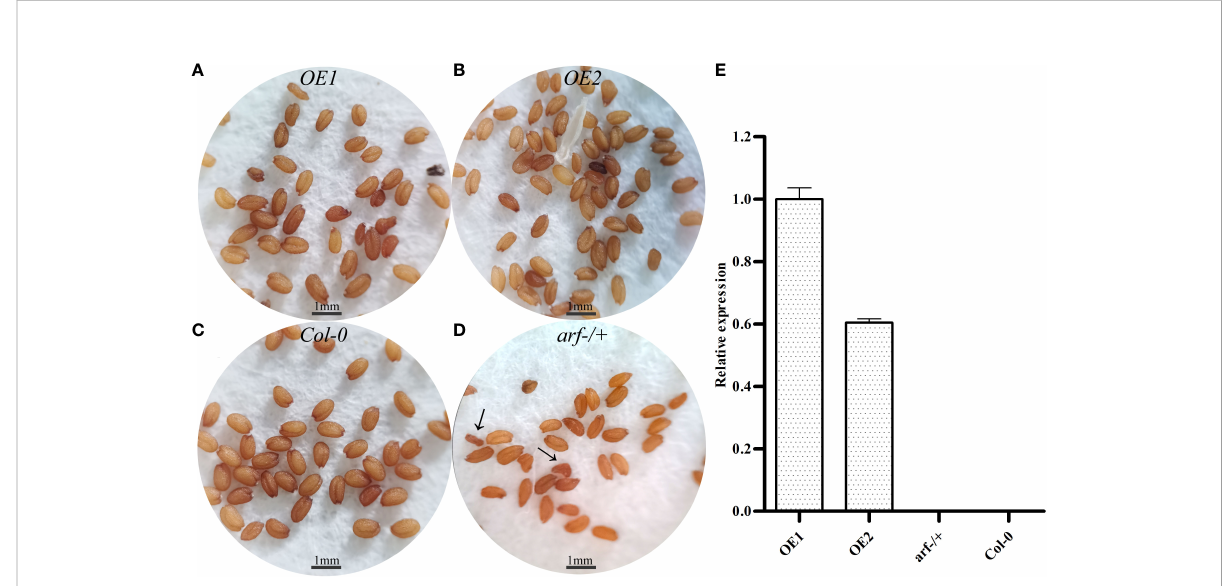
FIGURE 4 Phenotypes of transgenic A. thaliana overexpressing MsARF5 . (A-D) : Seed morphology of OE1, OE2, WT ( Col-0 ) and arf-/+ (heterozygous mutant of AtARF5 ) (E) : Results on RT-qPCR of transgenic plants